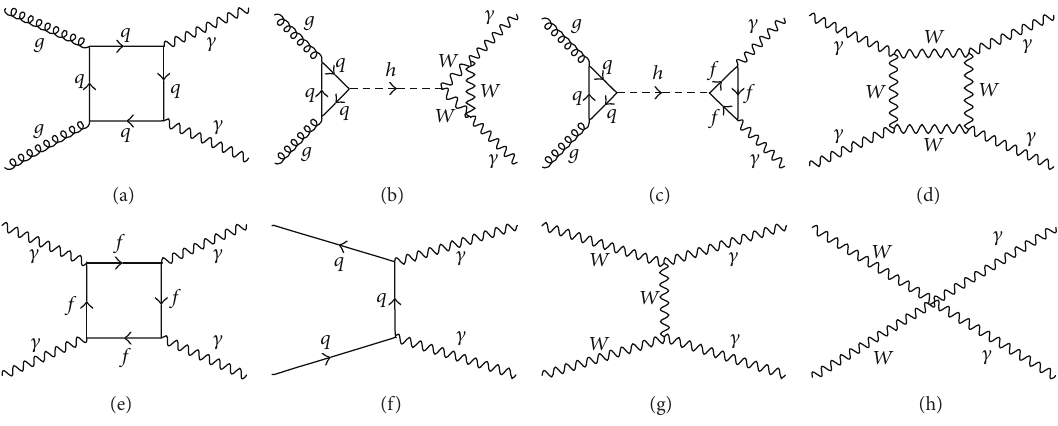
Figure 5: The subprocess Feynman diagrams for diphoton